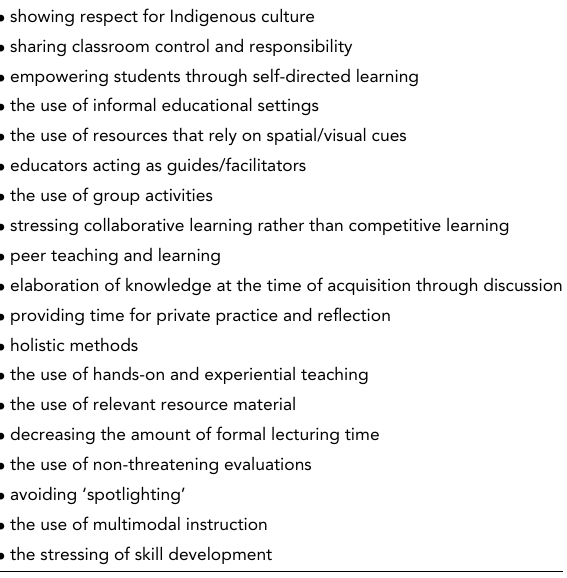
Educational Strategies Shown to Have a Positive Impact on the Academic Performance of North American Indigenous